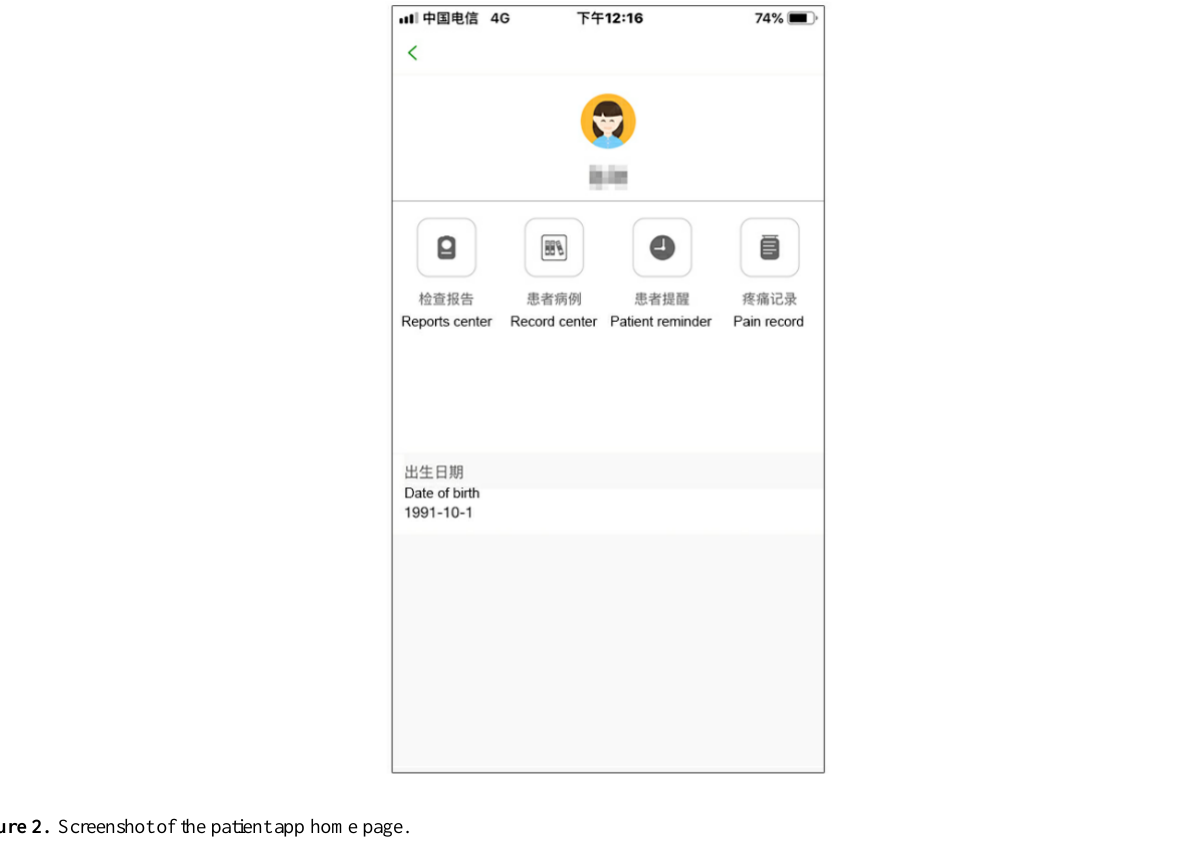
Figure 1. Screenshot of the medical experts’search page.